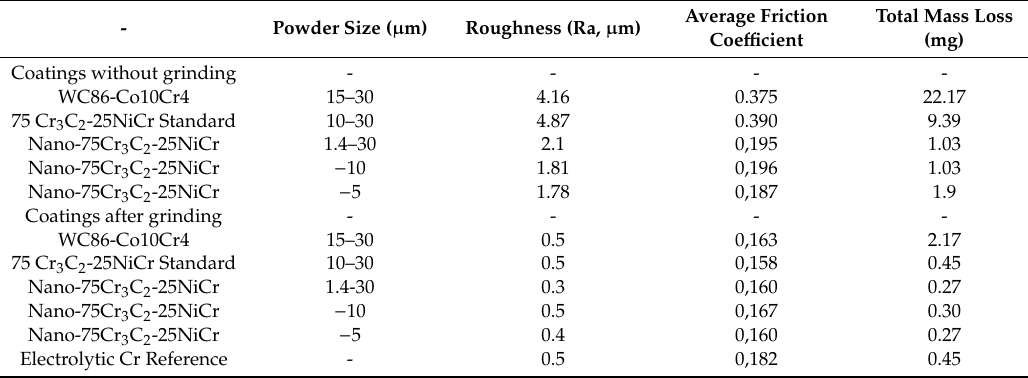
Table 7. Cylinder-on-disc test results.